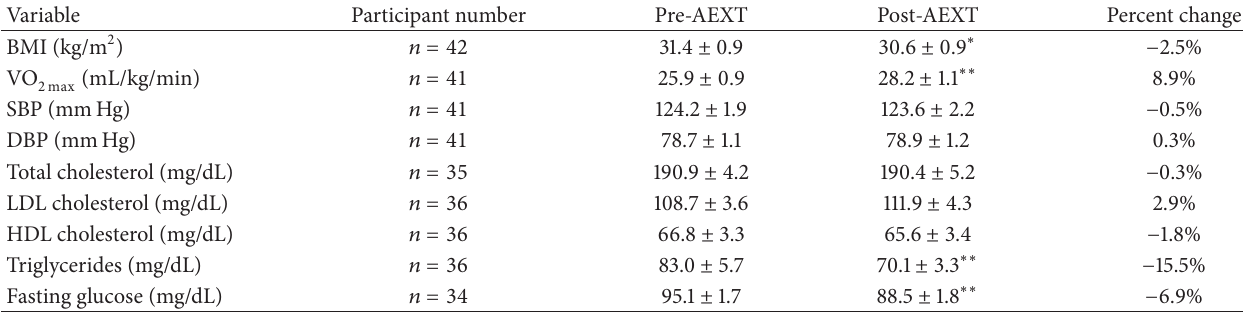
Table 1: Laboratory values of participants before and after